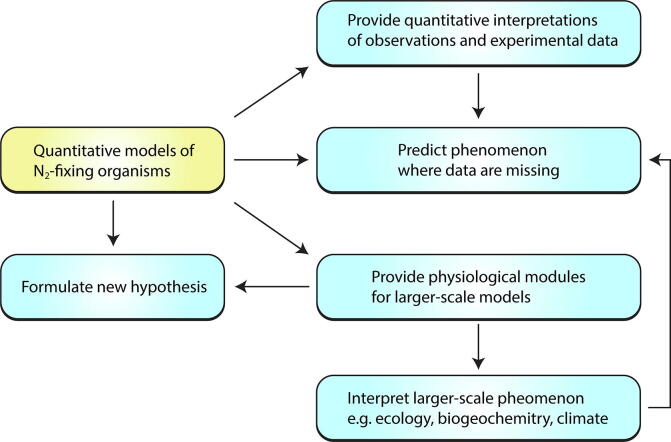
Roles of quantitative models of N2 fixers. Arrows indicate causes and effects.